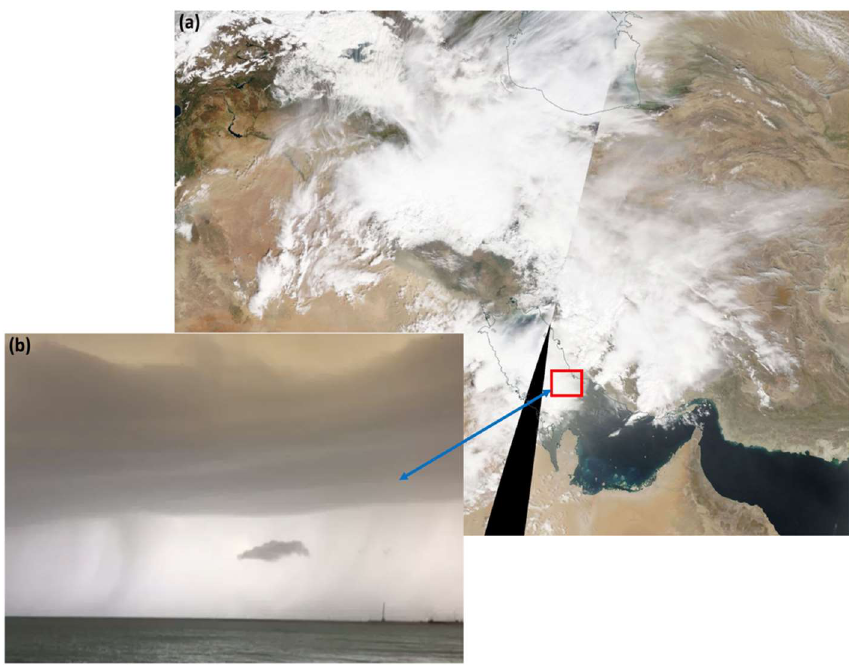
Figure 7. The map from the visible band of MODIS sensor for 3:45 UTC on 19 March 2017 ( a ), the image of the shelf clouds and CB formed on the studied area taken at 3:15 UTC ( b ). The red rectangle indicates the study area (image source: authors).